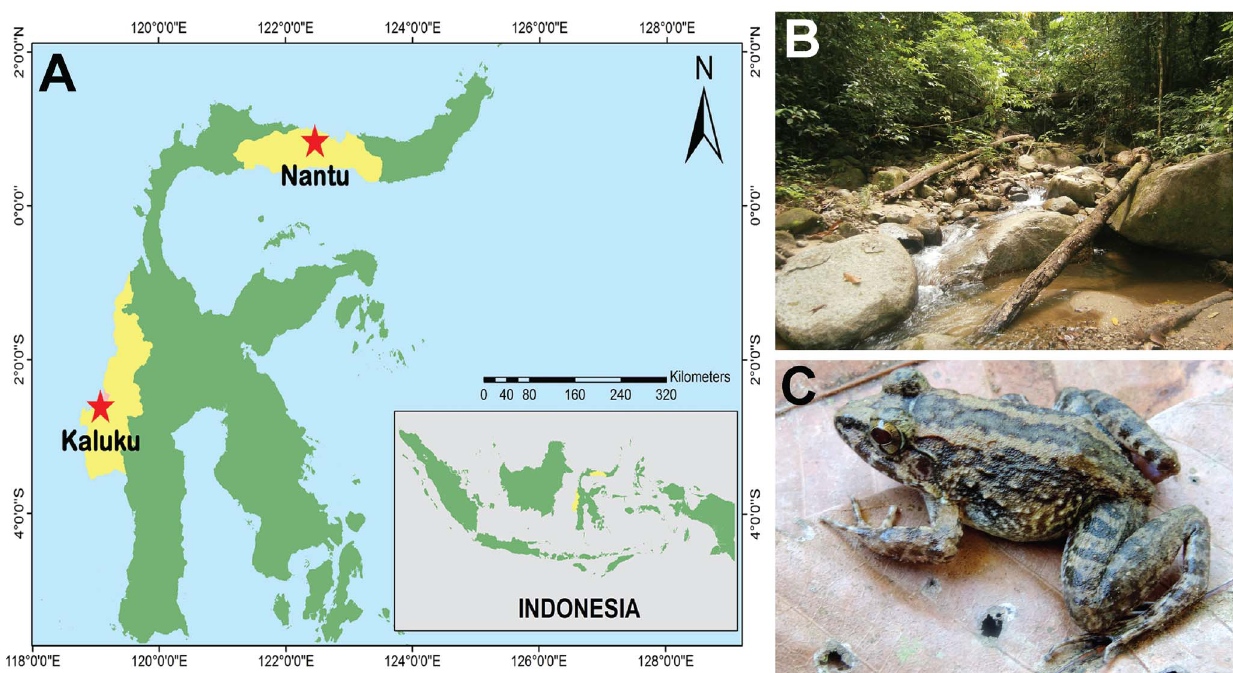
Fig. 1. Collection locality, habitat and live Limnonectes larvaepartus. (A) Collection locality of Limnonectes larvaepartus at Bontula, Nantu Wildlife Sanctuary, Gorontalo Province, Indonesia, (B) habitat of L. larvaepartus at Bontula, and (C) an adult female L. larvaepartus (MZB Amp 23978) in